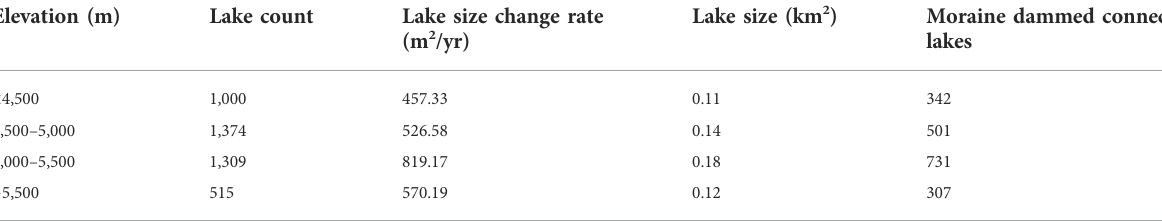
TABLE 2 Elevation wise lake characteristics distribution in the